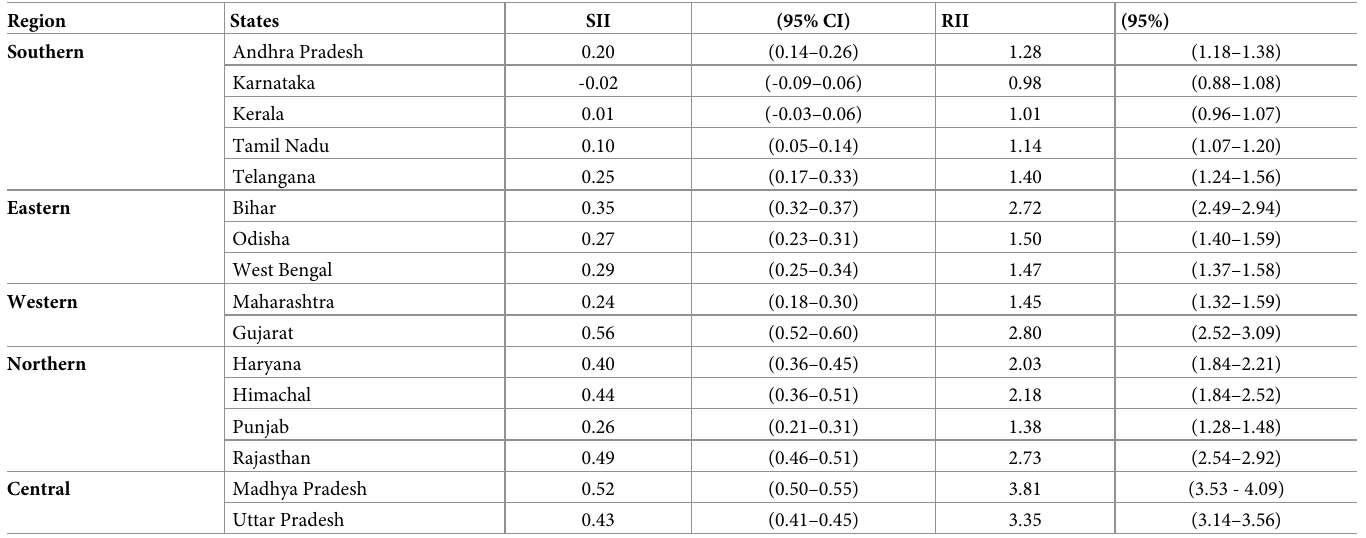
Table 3 provides the distribution of levels of inequalities across different socio-economic categories. Overall, the level of inequality was invariably high for central and northern regions except Punjab. For instance, the SII discerning the average difference in utilisation across wealth quintiles are outrageously high in Haryana and Uttar Pradesh. On the other hand, the states of Karnataka demonstrated lower levels of SII. The RII scores indicating the average ratio of utilisation across wealth quintiles was highest in Haryana with a score value of 2.01. On the other hand, in the states of Punjab, Tamil Nadu and West Bengal hovered around an RII score of 1. Table 4 illustrates the state-wise estimation results of SII and RII for Co-Cov in India. The states of Gujarat (56 percent), Madhya Pradesh (52.4 percent) and Rajasthan (48.5 percent) Table 4. SII and RII of Co-Coverage indicator across major Indian states. Region